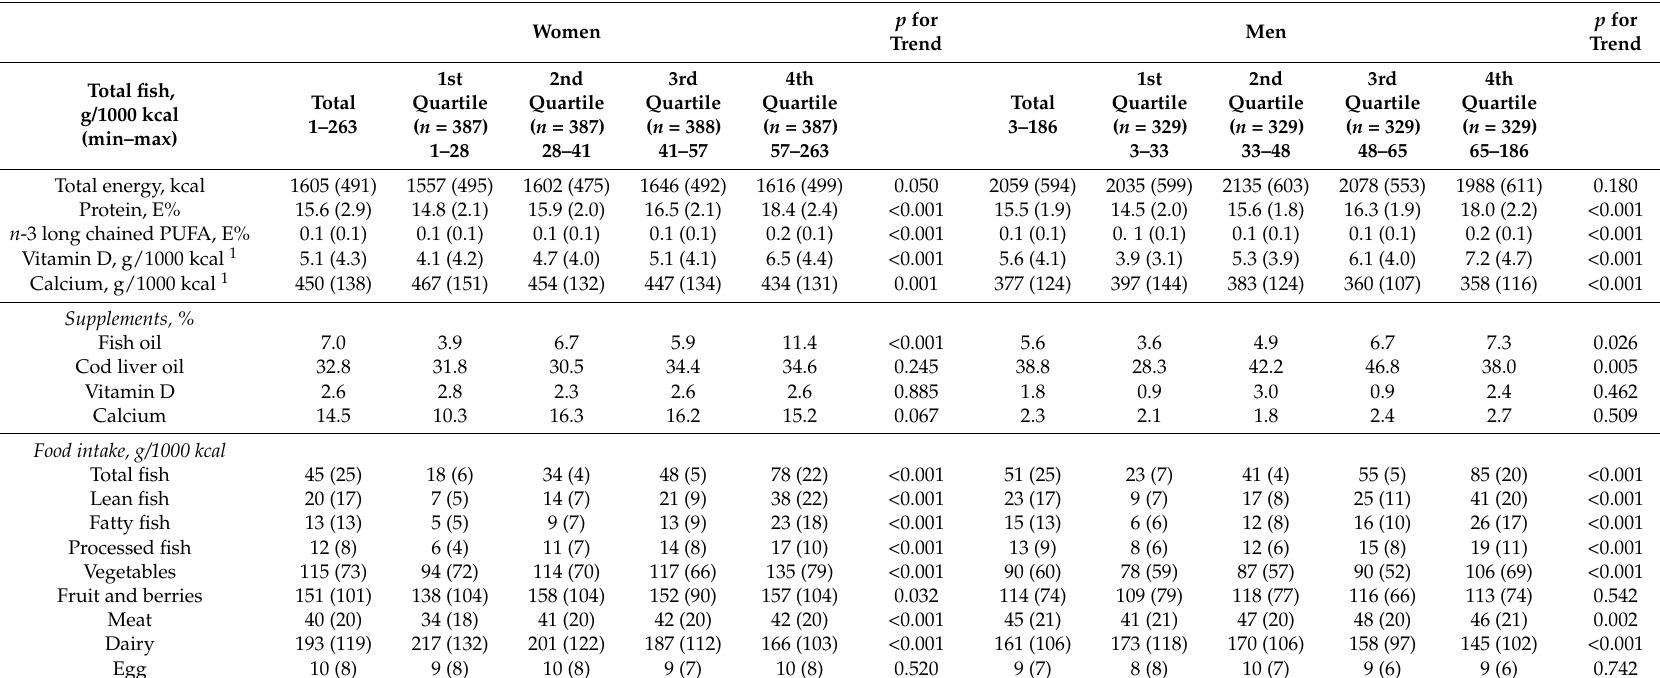
Table 2. Baseline (1997–1999) dietary intake of men and women (age 71–74 years) by sex-specific quartiles of total fish intake. The Hordaland Health